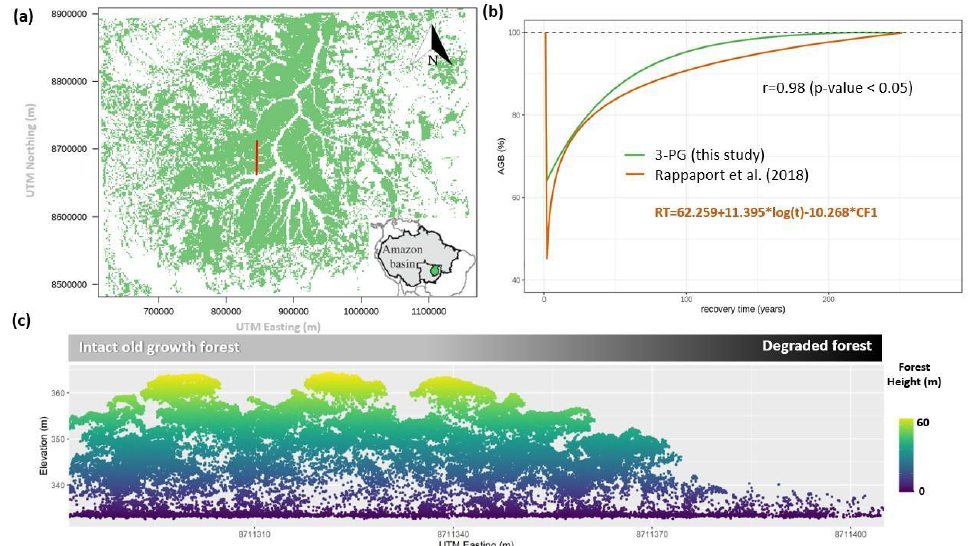
Figure 5. Airborne light detection and ranging (lidar) data were sampled (red line) in Feliz Natal, within the Xingu basin (light green), Brazilian state of Mato Grosso ( a ). The forest growth model (3-PG green line) shows the relationship between aboveground biomass (%) and recovery time in years. We compared it with a lidar-derived model of recovery time in stands that were logged and burned once (CF1 refers to once-burned) [25] (orange line) ( b ). A sample of vertical profile of a recovering forest which was degraded by fire and selective logging ( c ). The discrete return lidar data used for creating the transect figure were acquired in 2018 with a point density of 22.98 points m − 2 covering an area of 2891.25 ha in Feliz Natal, Mato Grosso, Brazil [25], as part of the Sustainable Landscapes Brazil project program (data available from: https://www.paisagenslidar.cnptia.embrapa.br/webgis/; details of airborne lidar (ALS) data acquisitions are presented in the supplementary material, Table S2).